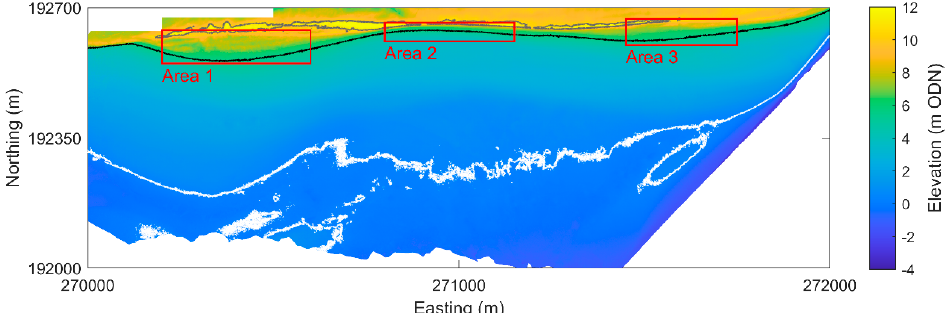
Figure 7. A morphological map of the study area. The contours indicate the mean sea level contour (white), the highest astronomical tide contour (black) and a contour at 10.75 m ODN providing an indication of the frontal dune crest (grey). Red boxes indicate the areas displayed in greater detail.